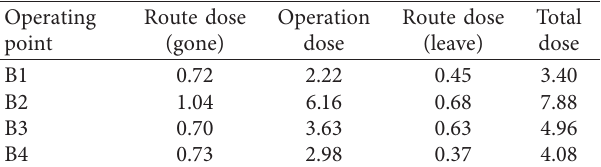
Table 4: Dose results of four operation plans.